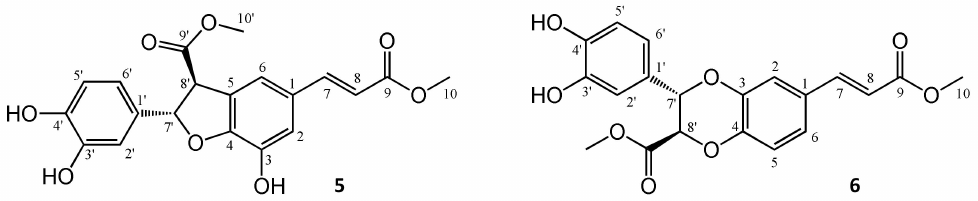
Figure 4. Structures of oxidized products isolated from the reaction of methyl ca ff eate ( cm ) with AAPH. For both compounds 5 and 6 , only one enantiomer is shown for clarity.